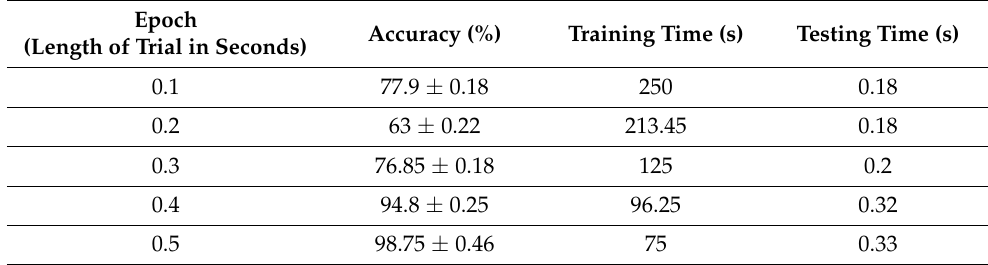
Table 2. Performance of the proposed method with different epoch lengths and selected